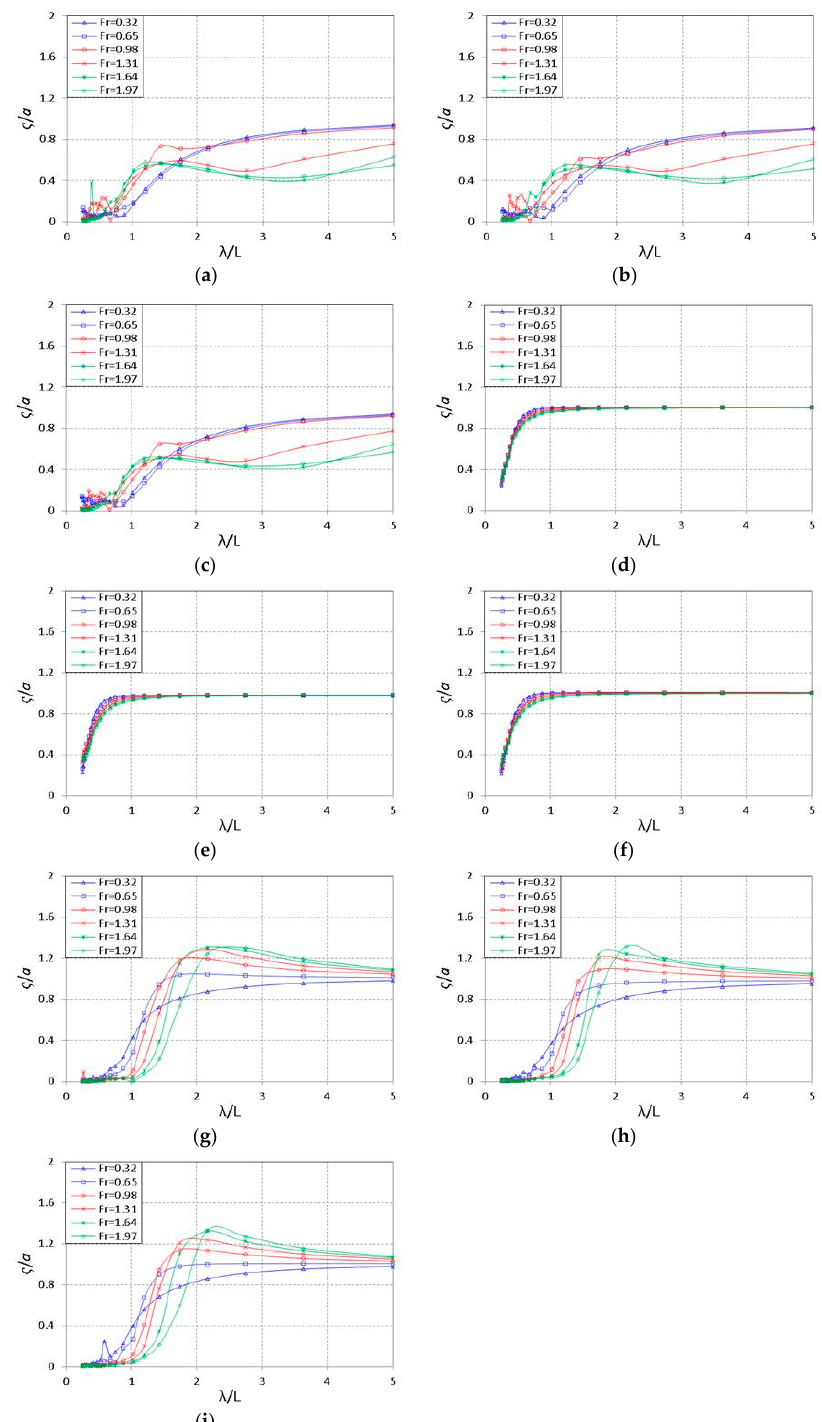
Figure 7. RAO comparison of the heaving motion for various Froude numbers and the trim angles of ( a ) τ = 0°, ( b ) τ = 1°, or ( c ) τ = 2° when μ = 0°; ( d ) τ = 0°, ( e ) τ = 1°, and ( f ) τ = 2° when μ = 90°; and ( g ) τ ( a ) τ = 0 ◦ , ( b ) τ = 1 ◦ , or ( c ) τ = 2 ◦ when µ = 0 ◦ ; ( d ) τ = 0 ◦ , ( e ) τ = 1 ◦ , and ( f ) τ = 2 ◦ when µ = 90 ◦ ; and ( g ) = 0°, ( h ) τ = 1°, and ( i ) τ = 2° when μ = 180°. τ = 0 ◦ , ( h ) τ = 1 ◦ , and ( i ) τ = 2 ◦ when µ = 180 ◦